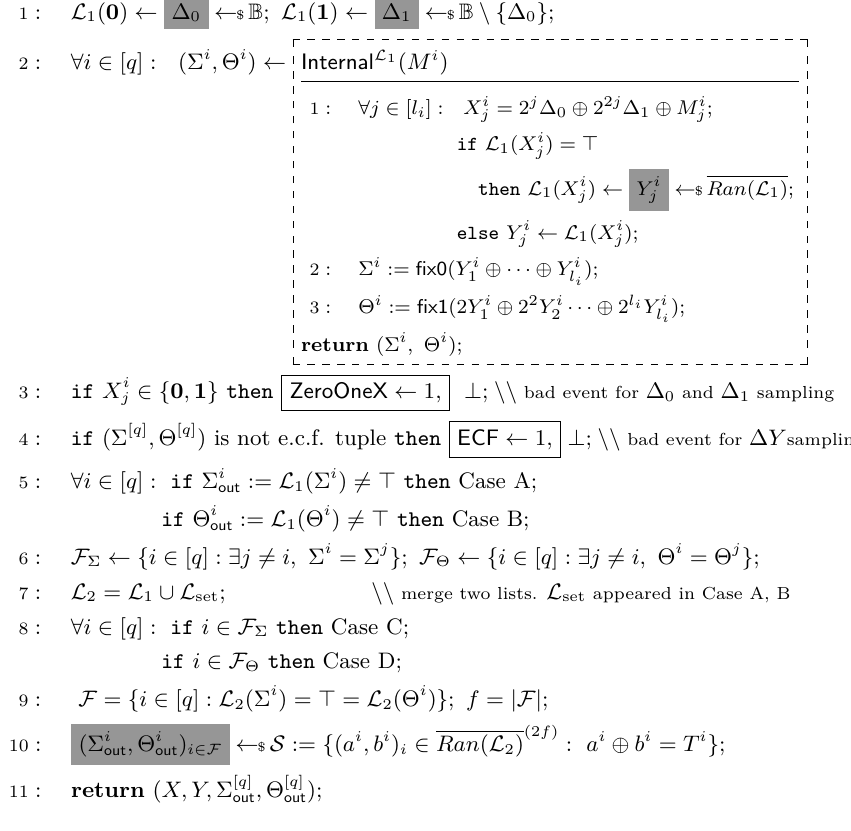
Figure 5.1: Ideal oracle $: Boxed statements denote bad events. Whenever a bad event is set to 1, the oracle immediately aborts (denoted as ⊥ ) and returns the remaining values of the transcript in any arbitrary manner. So, if we proceed further we can surely assume that the event ⊥ (and so any bad event so far) does not hold. We write > when the value of a variable is not defined. Shaded box is used to represent the uniform sampling in ideal